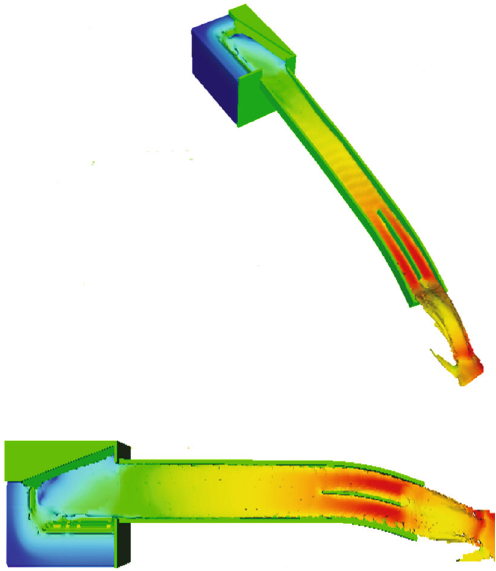
Figure 16: Solving numerically the problem of stagnation zone by adding separator wall.